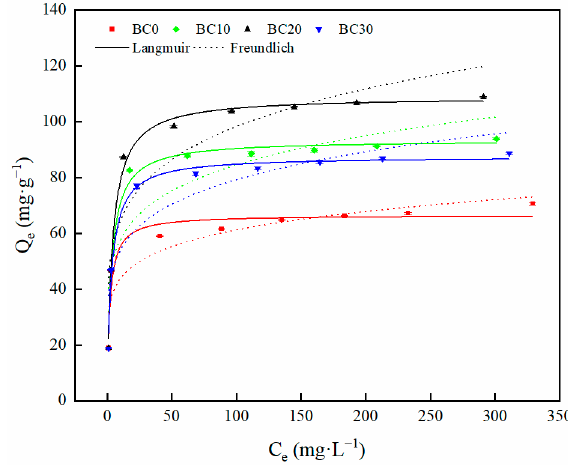
Figure 6. Adsorption isotherms of Cd 2+ by biochars: Langmuir and Freundlich models. Table 3. Adsorption isotherm constants for the Cd 2+ by biochars derived from HS-PP blends. Langmuir Biochars